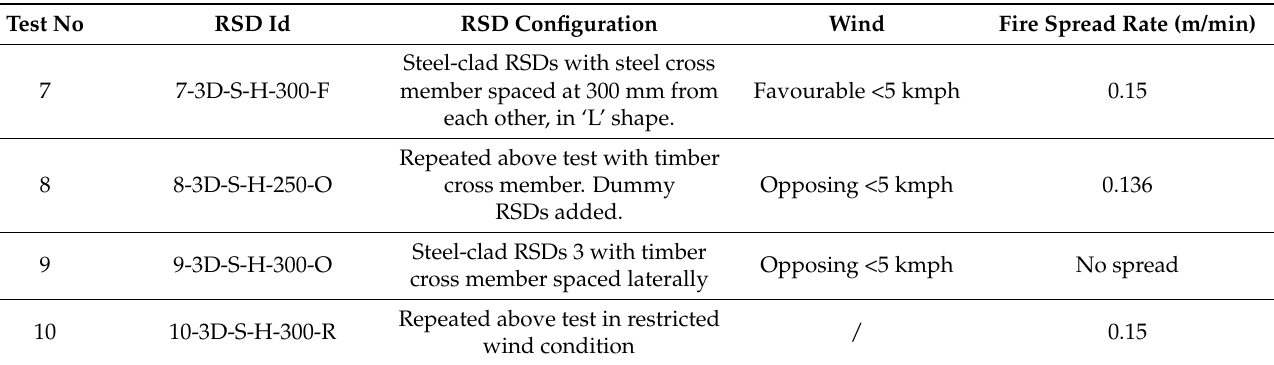
Table 7. Testing matrix of three RSD